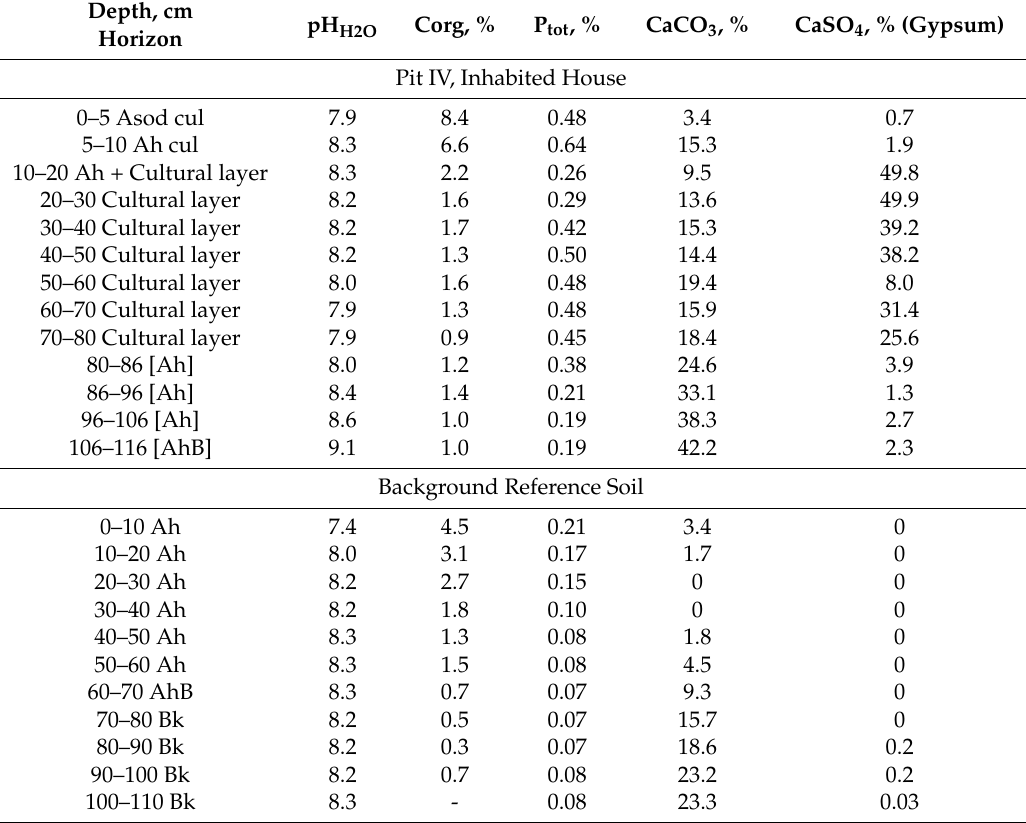
Table 1. Chemical properties of soils and cultural